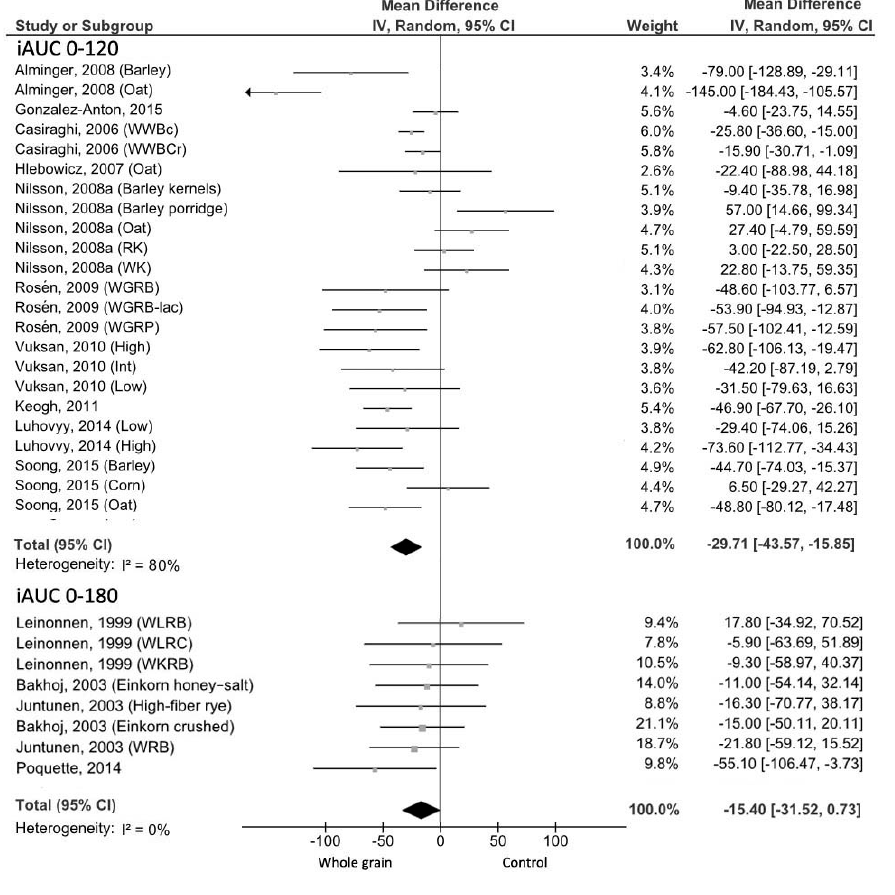
Figure 2. Forest plot of the meta-analysis carried out to investigate the effect of whole